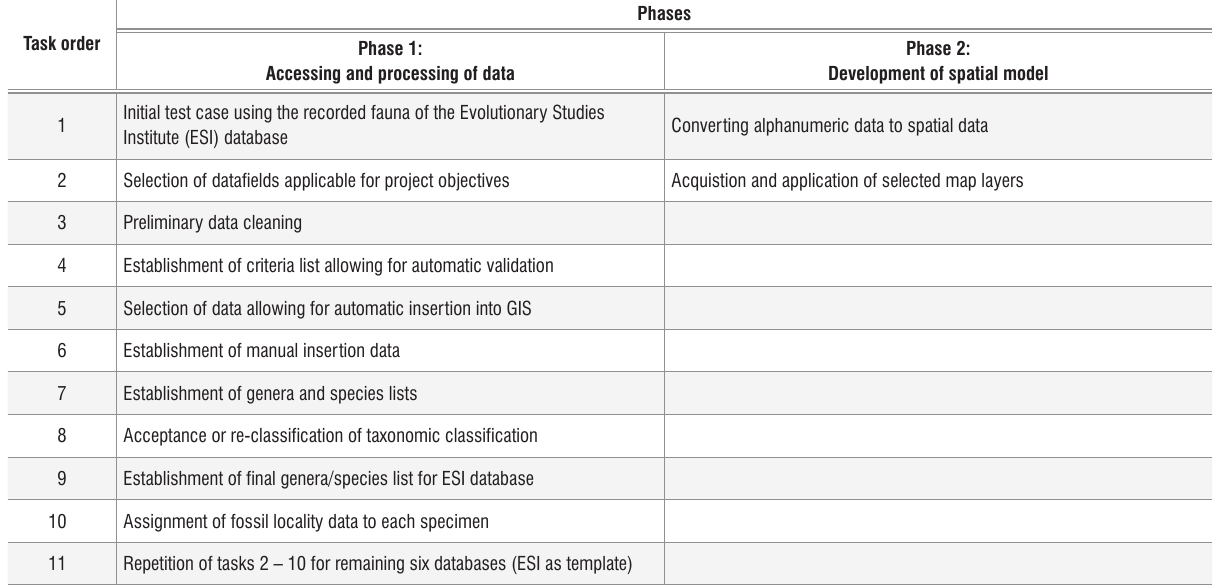
Table 2: Summary of specific processes for presenting digitised Beaufort Group data